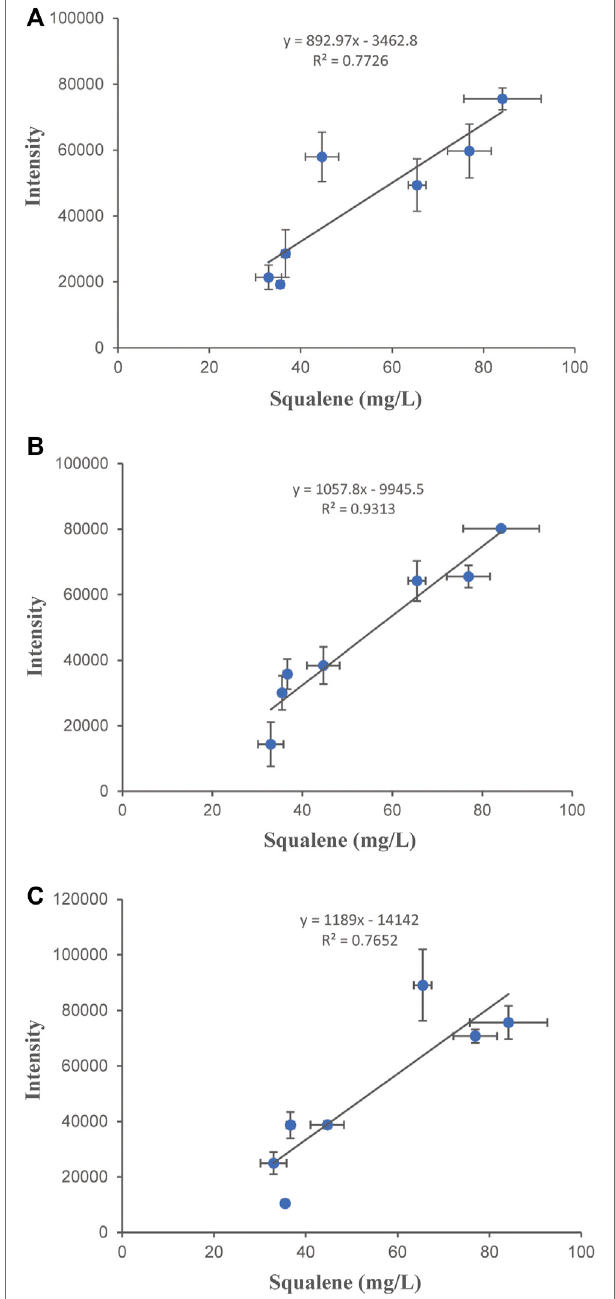
FIGURE 5 | Establishment of the high-throughput intracellular squalene assay. Relationship between fl uorescence intensity and squalene production at different Nile Red cell-staining concentrations: (A) 0.5 μ g/ml; (B) 1 μ g/ml; (C) 1.5 μ g/ml. Error bars show SD values.